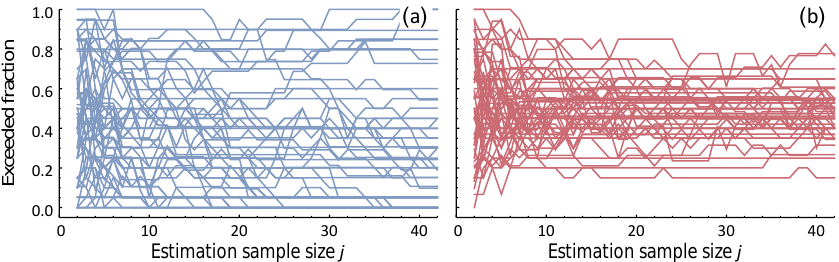
Figure 5. Fraction of each of the selected 60 station’s final 20 years with capacity factor exceeding its P50 estimate ˆ µ j,(cid:96) for actual (a) and randomized (b)